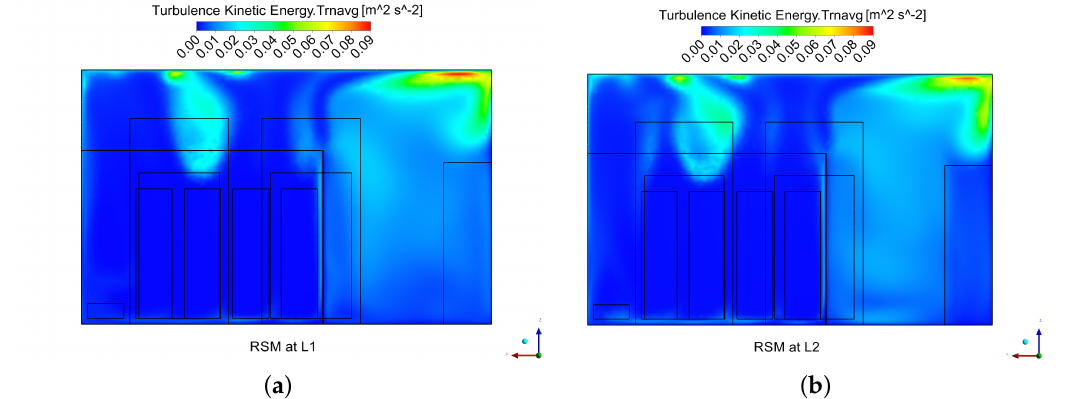
Figure 10. Turbulent kinetic energy on planes at ( a ) L1 and ( b ) L2 for